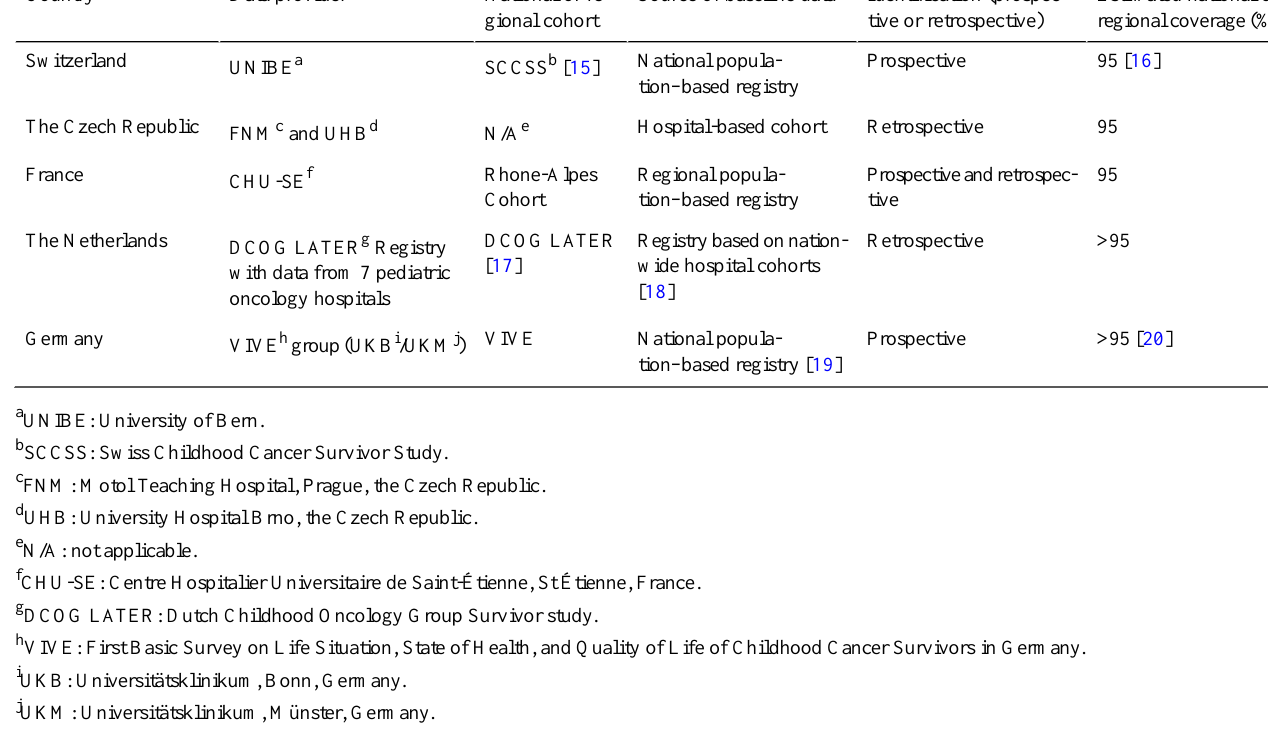
Estimated national or